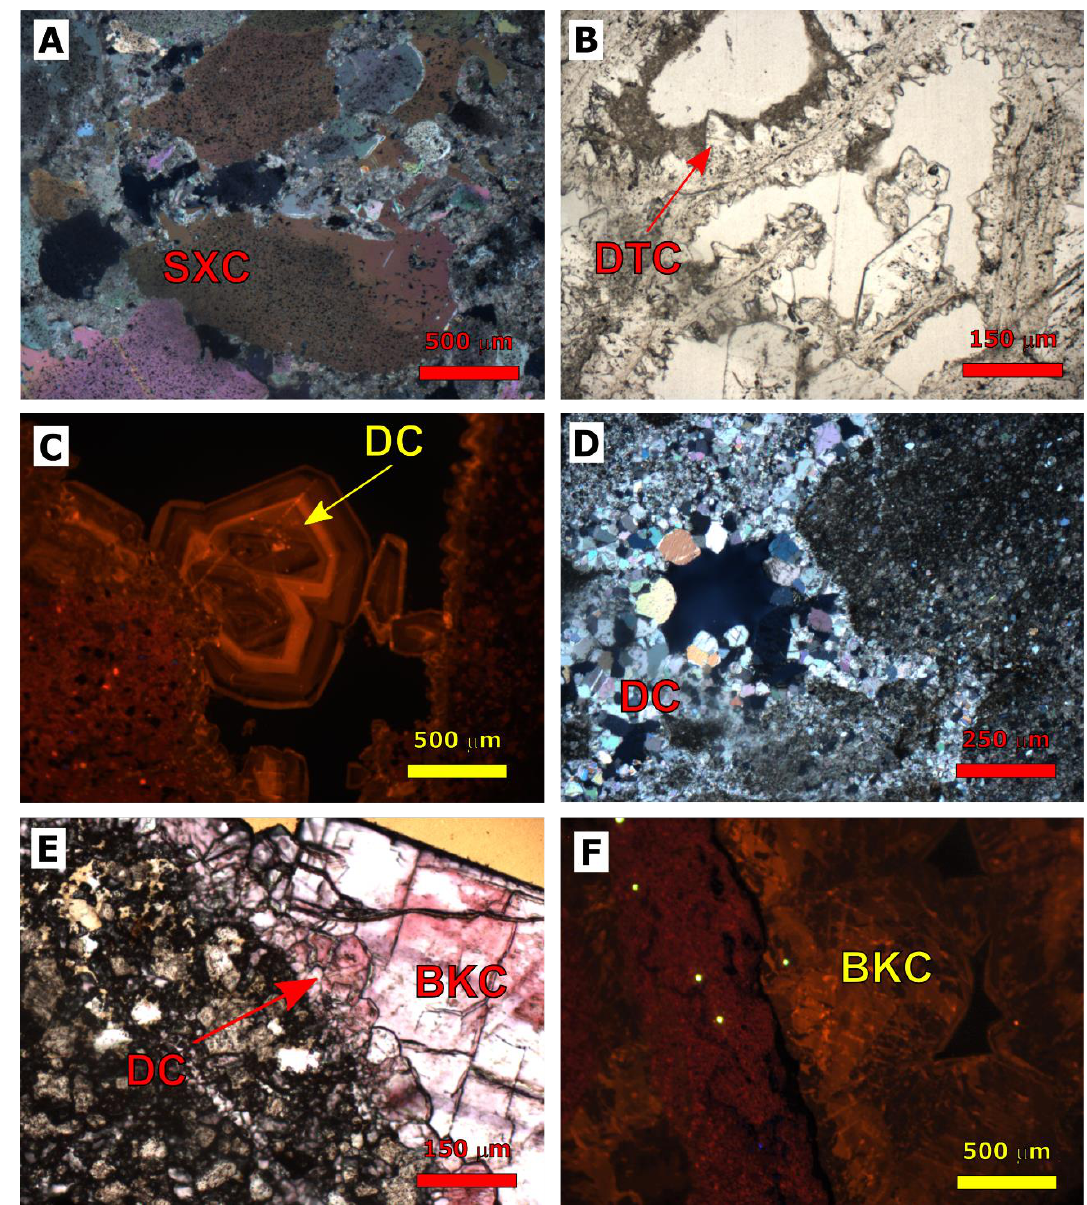
Figure 9. Calcite cementation in Devonian formations. ( A ) Photomicrograph (XPL) of syntaxial overgrowth calcite cement (SXC) on echinoderm skeletal fragments in a bioclastic grainstone. Sample 1-10; well: DGR1-CR10 (1); depth: 48.65 m; ( B ) photomicrograph (PPL) of dogtooth calcite cement (DTC) growing normally with respect to the surface of the intraskeletal chambers in a coral from a bioclastic grainstone. Sample 1-11; well: DGR1-CR10 (2); depth: 49.7 m; ( C ) CL photomicrograph of fracture-filling drusy calcite cement (DC) showing dull to bright zoned luminescence. Sample 1-13; well: DGR1-CR30 (1); depth: 26.95 m; ( D ) photomicrograph (XPL) of drusy calcite cement (DC) showing increasing crystal sizes towards the center of a fracture in a brecciated cherty dolostone. Sample 1-13; well: DGR1-CR30 (1); depth: 104.05 m; ( E ) photomicrograph (PPL—after staining) of non-ferroan, drusy calcite cement (DC) lining a fracture subsequently filled by non-ferroan blocky calcite (BKC) in fine crystalline dolostone. Sample 1-13; well: DGR1-CR30 (1); depth: 104.05 m; ( F ) CL photomicrograph of bright luminescent fracture-filling blocky calcite cement (BKC). Sample 8-1; well: DGR8-CR10; depth: 22.71 m.